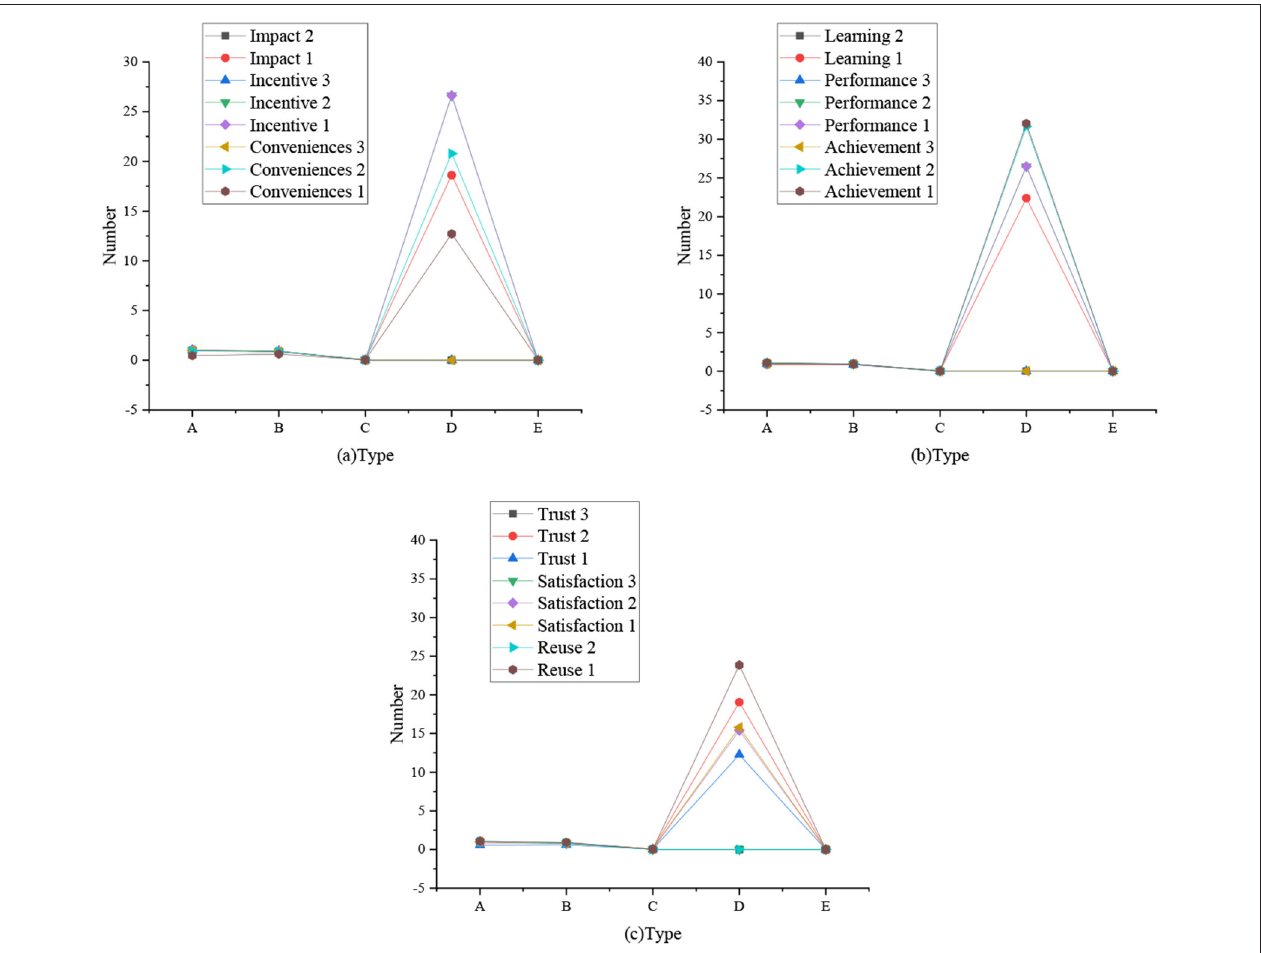
FIGURE 3 | Regression weight statistics of various factors ( a : regression weight of influencing, incentive, and convenience factors; b : regression weight of learning, performance, and achievement factors; c : regression weight of trust, satisfaction, and reuse factors; A: non-standard; B: standardized C: SE value; D: T -value; E: P -value).